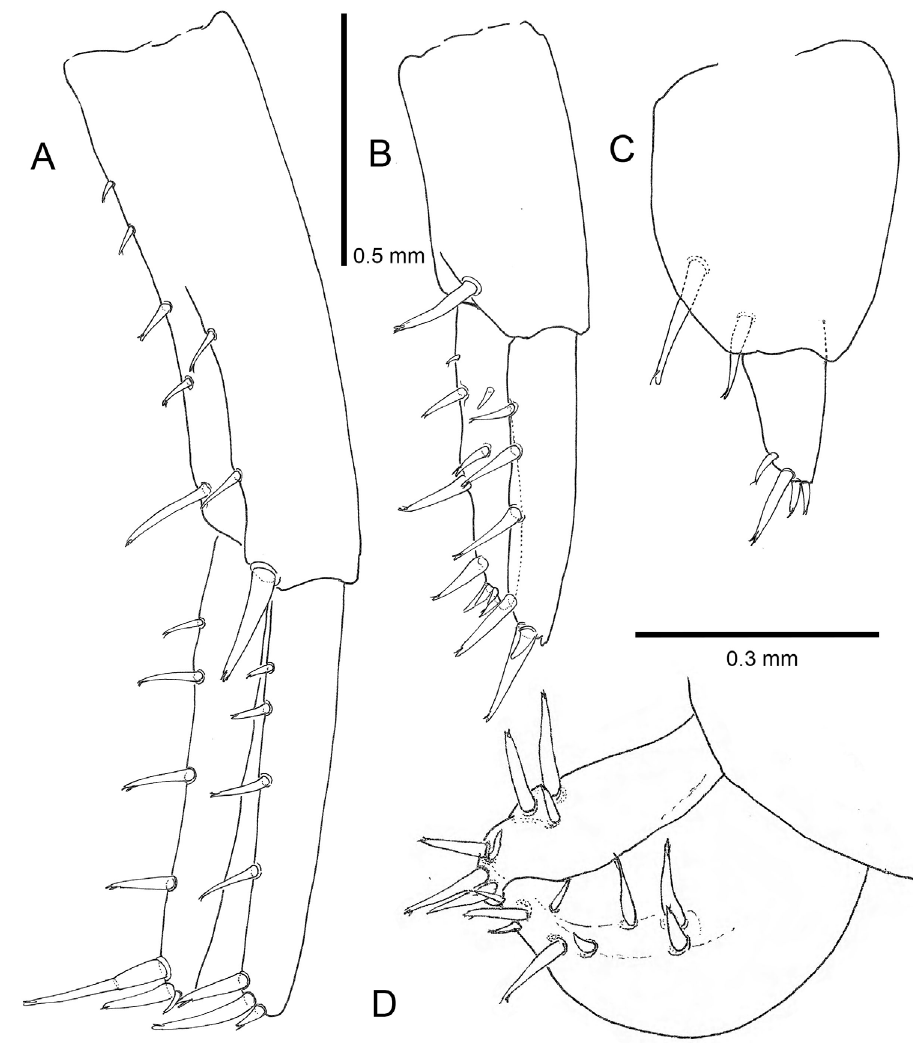
Figure 7. Cryptorchestia ruffoi sp. n., paratype male 10.4 mm (RMNH) A uropod 1 B uropod 2 C uropod 3 D